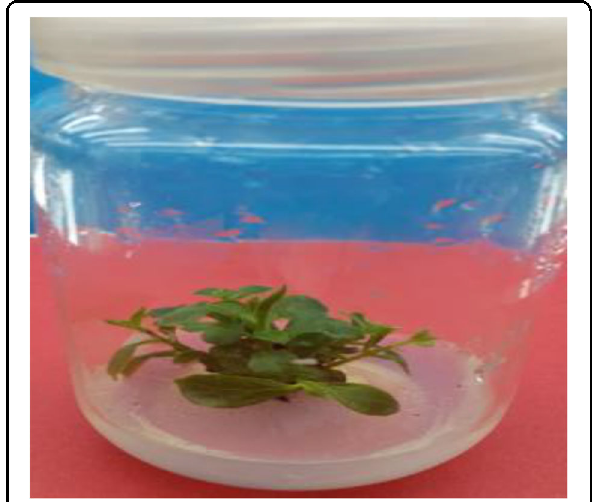
Fig. 3 Shootlets regenerated from internode calli explants of Diospyros kaki L. cv. Costata cultured on ½ MS-media supplemented with 1 mg/l Zt + 2 mg/l IAA + 4 mg/l BAp + 0.5 g/l PVP (cultured was incubated under light condition (2000 lux) at 26 ± 1 °C for 8